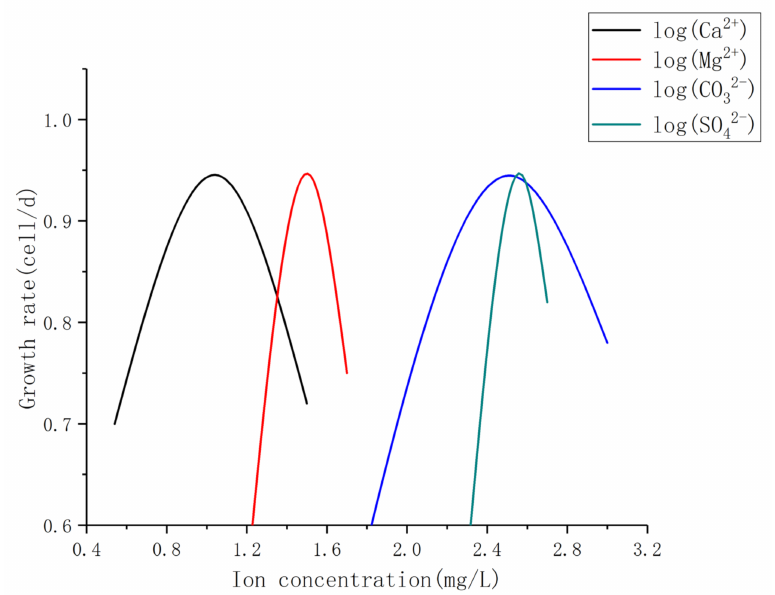
Figure 2. The influence curves of ion conditions on growth rate (Ca 2+ , Mg 2+ , Cl − , and SO 42 −